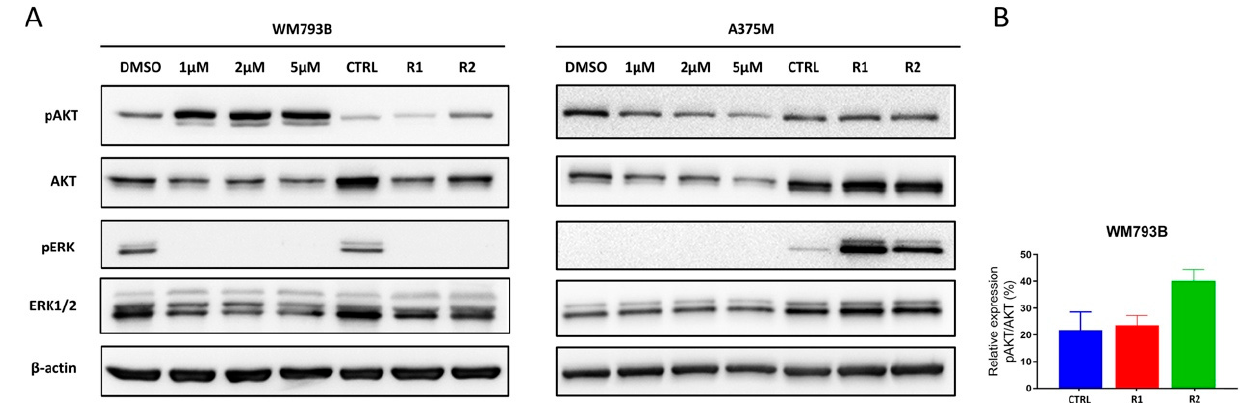
Figure 5. AKT and ERK phosphorylation/activation in vemurafenib treated and resistant melanoma cell lines. ( A ) The activity of signaling pathways in parental lines (CTRL) after short-term 24 h treatment with vemurafenib (1, 2, and 5 µ M) or DMSO, and in cell lines resistant to vemurafenib (R1 and R2) is analyzed by western blot. β -actin was used as a loading control. ( B ) Densitometric analysis of pAKT/AKT signals from two biological replicates shows activation of PI3K/AKT sig- naling pathway in vemurafenib-resistant primary melanoma cell line (WM793B-R).